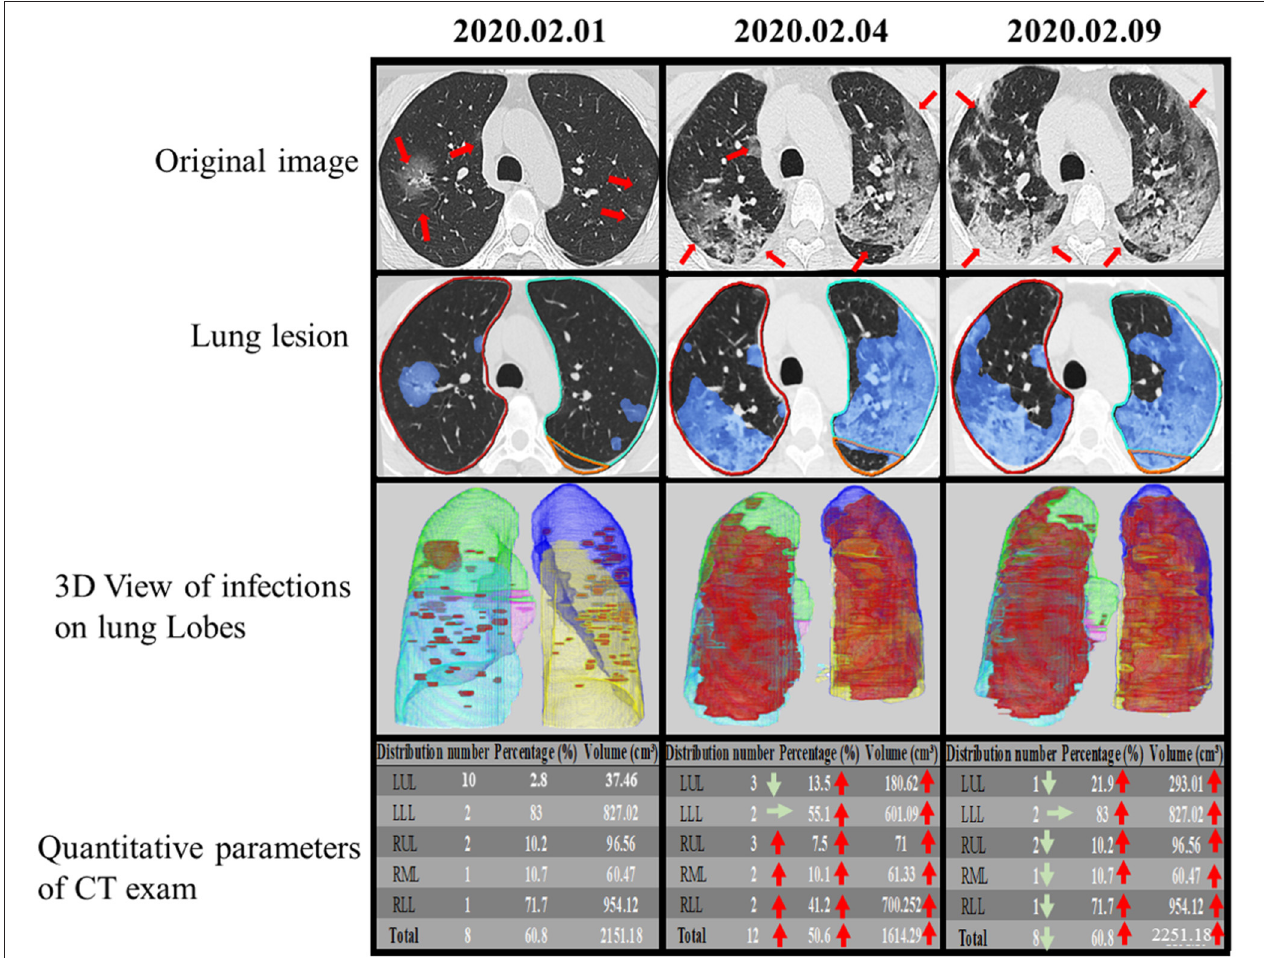
FIGURE 6 | Temporal lung changes of one confirmed case in ICU group on thin slice CT. A 52-year-old man with a history of fever, cough, and myalgia for 3 days. Original images obtained on the 1st day, the 4th day, and the 9th day after admission. Multiple GGOs were distributed in both lungs on initial. Follow up exams showed rapid progress of the GGOs with the reticular pattern. Infection lesion Images colored infection area in blue. 3D View of Infections on Lung Lobes showed opacities displayed in red, LUL in purple, LLL in yellow, RUL in green, RML in pink, RLL in blue. The quantitative parameters table showed the lesion percentage and volume in each lobe. LUL, left upper lobe; LLL, left lower lobe; RUL, right upper lobe; RML, right middle lobe; RLL, right lower